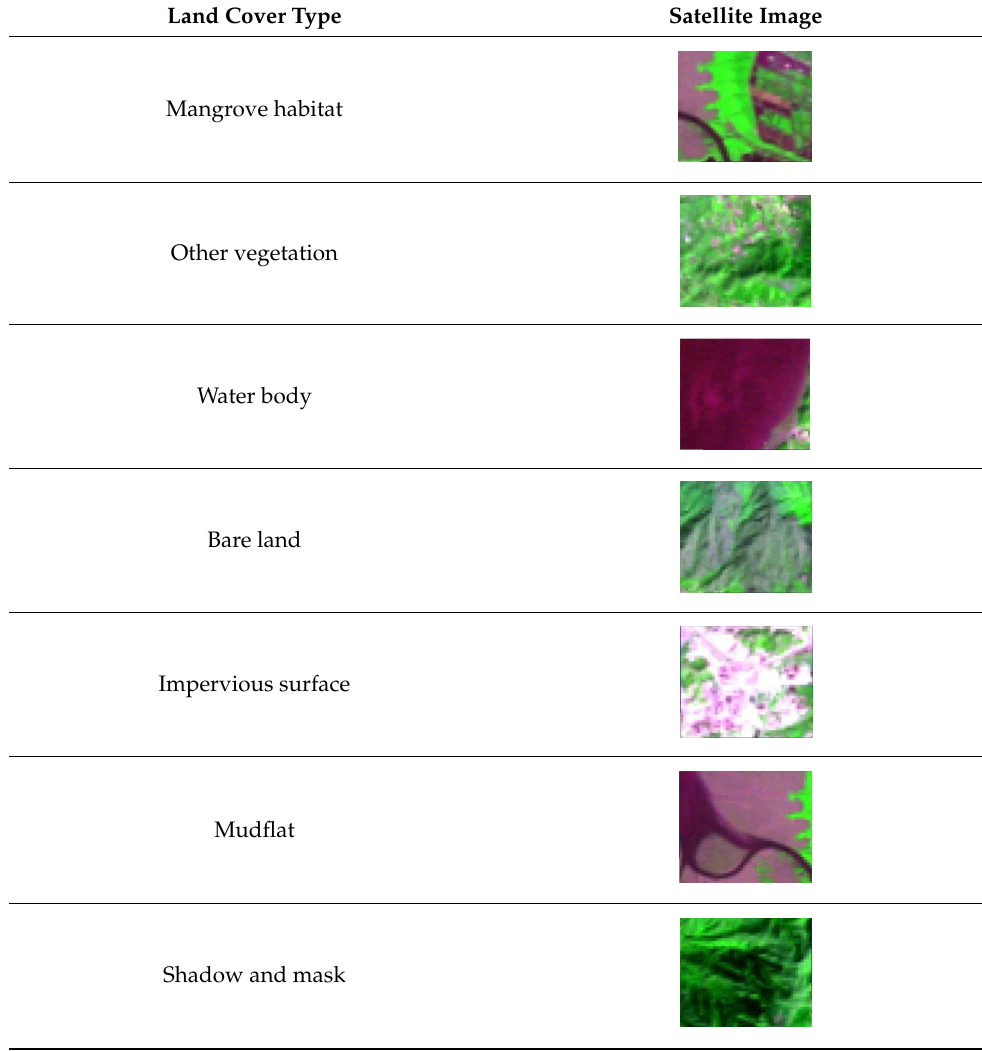
Table 2. The numbers of polygon and pixel samples selected for training and testing classification rules for Landsat and SPOT data, presented as polygon/pixel. Year